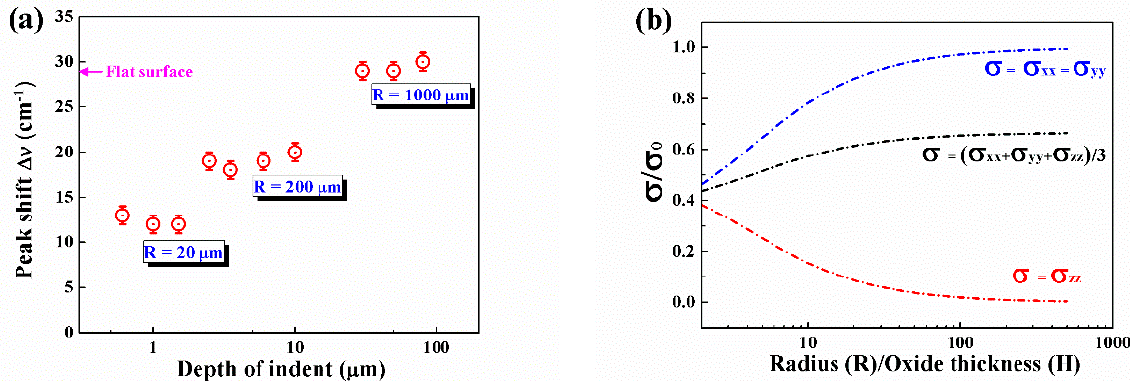
Figure 4. ( a ) Peak shift of the characteristic R-line of α -Al 2 O 3 scale formed at the central part of the indents on Fecralloy after oxidation at 1200 °C for 25 h as a function of indent radius and depth. ( b ) Normalised σ zz and σ xx ( σ yy ) as a function of the indent radius and oxide thickness ratio, R/H.